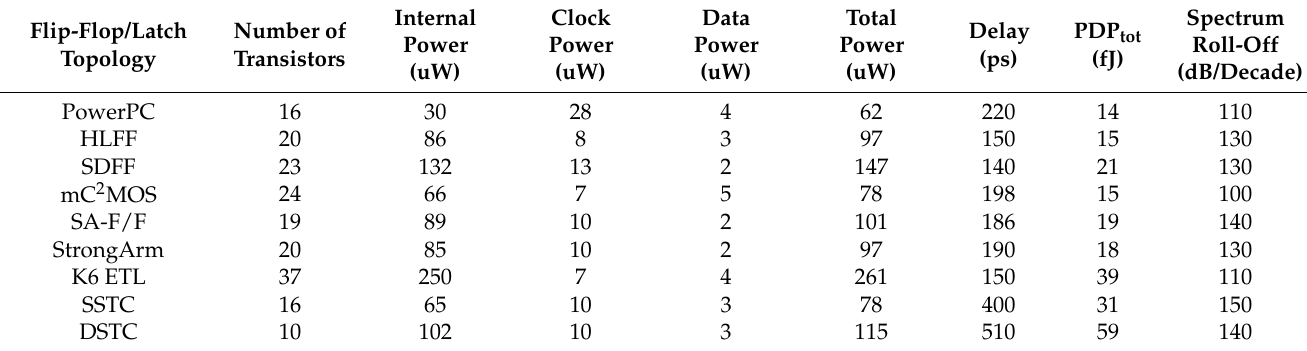
Table 4. Simulation results using the BSIM4 transistor model.